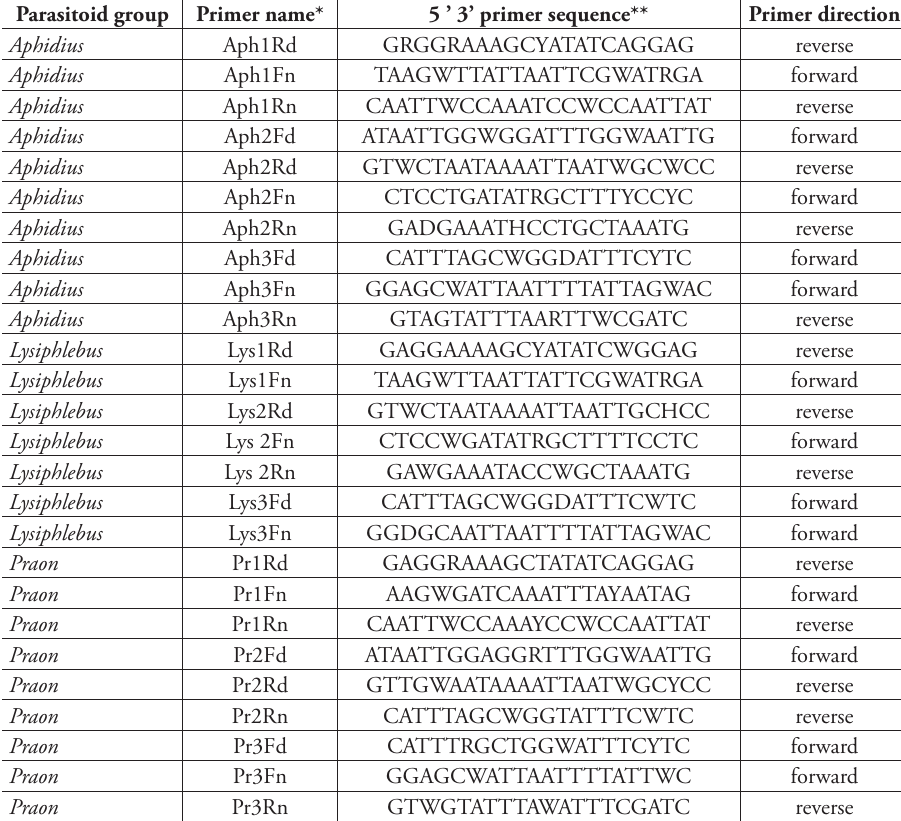
Table 3. The list of primers designed for the genera Aphidius , Lysiphlebus and Praon to amplify short frag- ments of COI barcoding region from dry specimens through direct and nested PCR analyses. Parasitoid